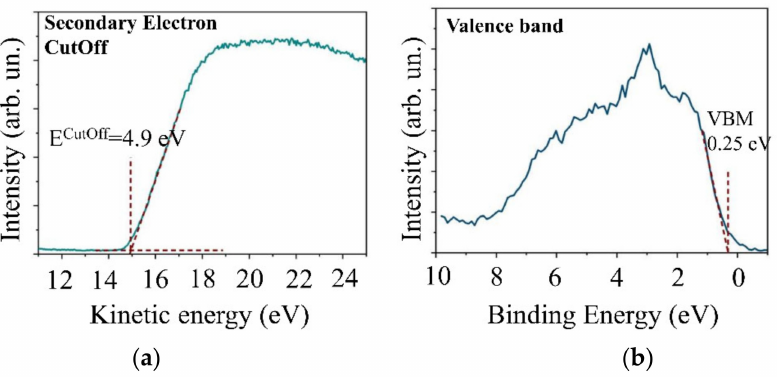
Figure 6. ( a ) XPS spectrum of secondary electrons cutoff and ( b ) evaluation of the valence band edge position for a WSe 2 film obtained by off-axis PLD on the surface of C(B) film.